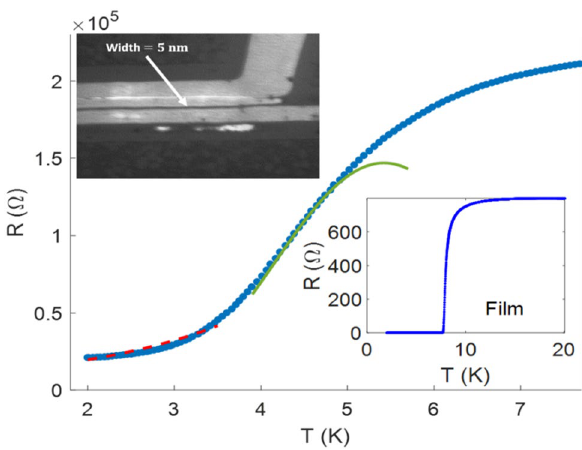
Figure 1. Resistance vs. temperature for the NbN nanowire (main panel) and the film (right inset). The solid and dashed lines in the main panel are fits to theoretical predictions for TAPS (Eq. (1)) and QPS (Eq. (2)), 2.1 10 5 (�) , width 5 ( nm ) , thickness 5 ( nm ) , respectively. The wire parameters are R n = ∗ = = resistivity = 87.5 (cid:31) µ � and T c ( at 0.9 R n ) = 6.5 ( K ) . Left inset shows HR-SEM image of the 5 nm wire. m (cid:30)